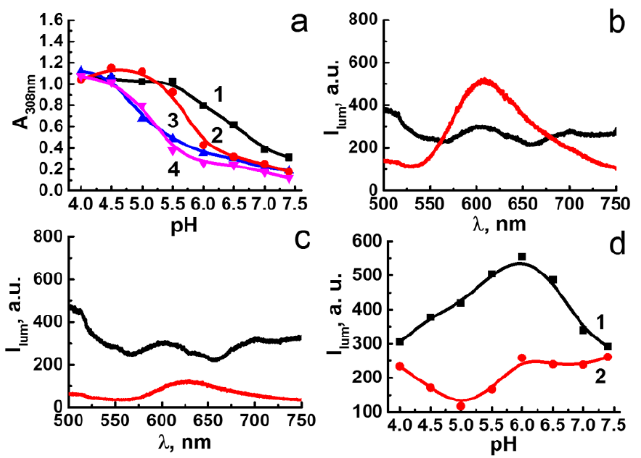
Figure 2. ( a ) Absorbance-pH plots for supernatant solutions of Au 2 Re 6 -S (1), Au 2 Re 6 -Se (2), LSZ-Au 2 Re 6 -S (3), and LSZ-Au 2 Re 6 -Se (4) colloids. ( b,c ) Luminescence of Re 6 -cluster unit in Au 2 Re 6 -S (b) and Au 2 Re 6 -Se (c) at pH = 7.4 (black lines), pH = 5.5 (b, red line), or pH = 5 (c, red line). C colloids = 22 µ M. ( d ) Luminescence-pH plots of Au 2 Re 6 -S (1) and Au 2 Re 6 -Se (2) colloids at λ max = 607 nm (1) and λ max = 630 nm (2).